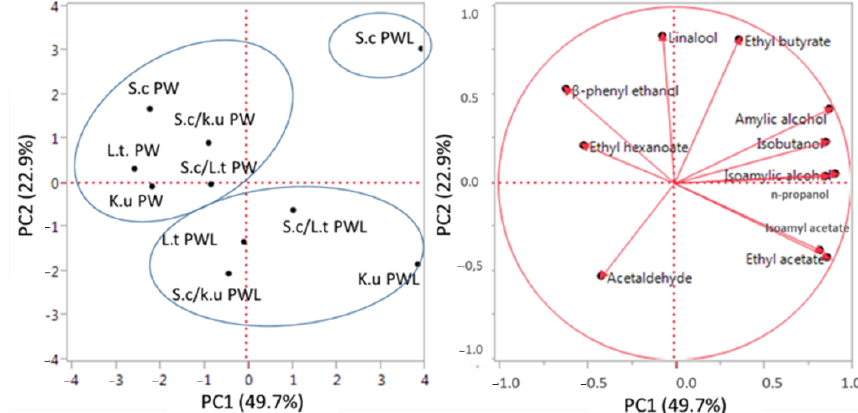
Figure 3. Principal component analysis for the main by-products and volatile compounds of craft beer obtained by different yeast strains in PW and PWL. The variance explained by principal component analysis (PCA) analysis is PC 1 49.7% X-axis and PC 2 22.9% Y-axis.